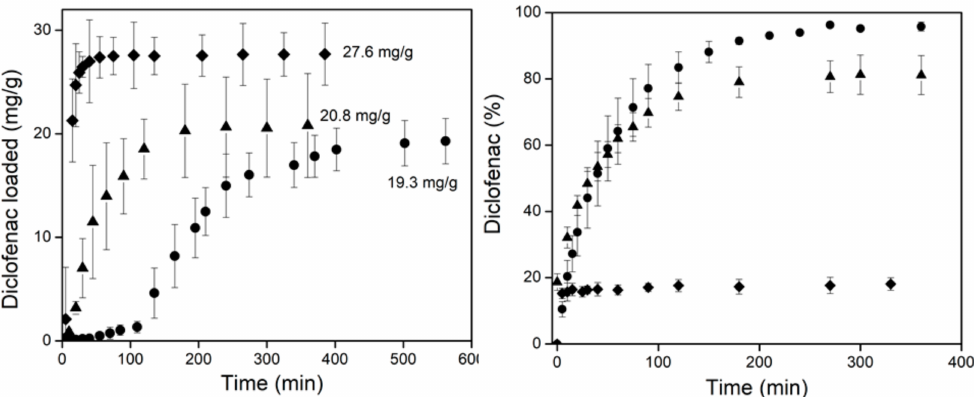
Figure 11. Loading ( left ) and release ( right ) profiles of diclofenac for different systems. ( ▲ ) net -CS and ( ● ) ( net -CS)- g -NVCL/AAc (32% graft) at pH 6.5 and 40 °C; ( ◆ ) ( net -CS)- g -NVCL/AAc (32% graft) preactivated at pH 5 and 40